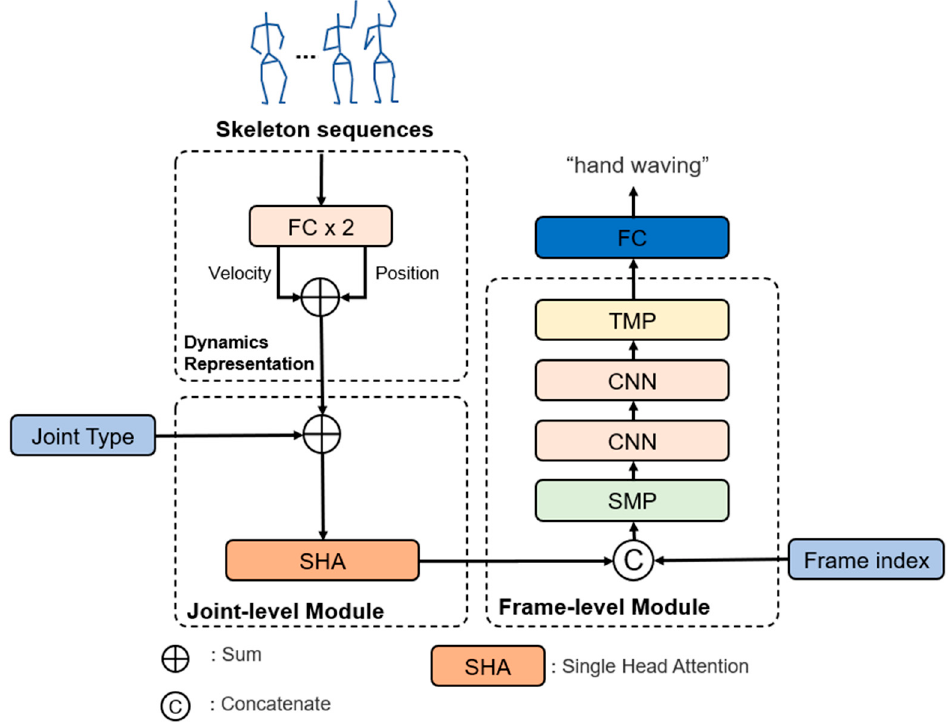
Figure 1. Illustration of the proposed SGN-SHA, which consists of three consecutive modules, i.e., dynamic representation, joint-level, and frame-level modules. The joint-level module can signifi- cantly reduce the numbers of operations and parameters by applying the proposed SHA instead of multiple GCNs.